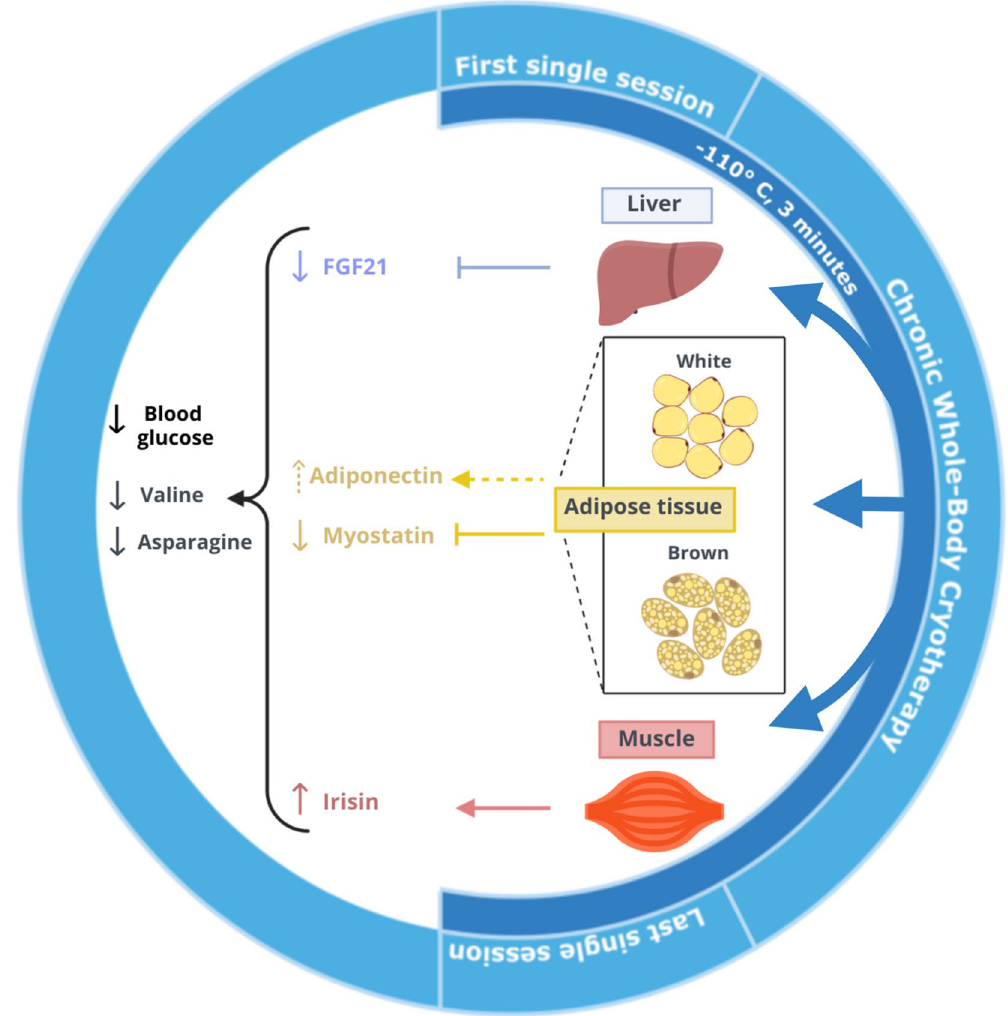
Figure 4. Graphical conclusion–proposed interpretation of the findings. WBC inhibited FGF21 in the liver, triggered skeletal muscle mass shivering, which lead to an increased release of irisin, and stimulated brown fat tissue to reduce myostatin and white fat tissue to release